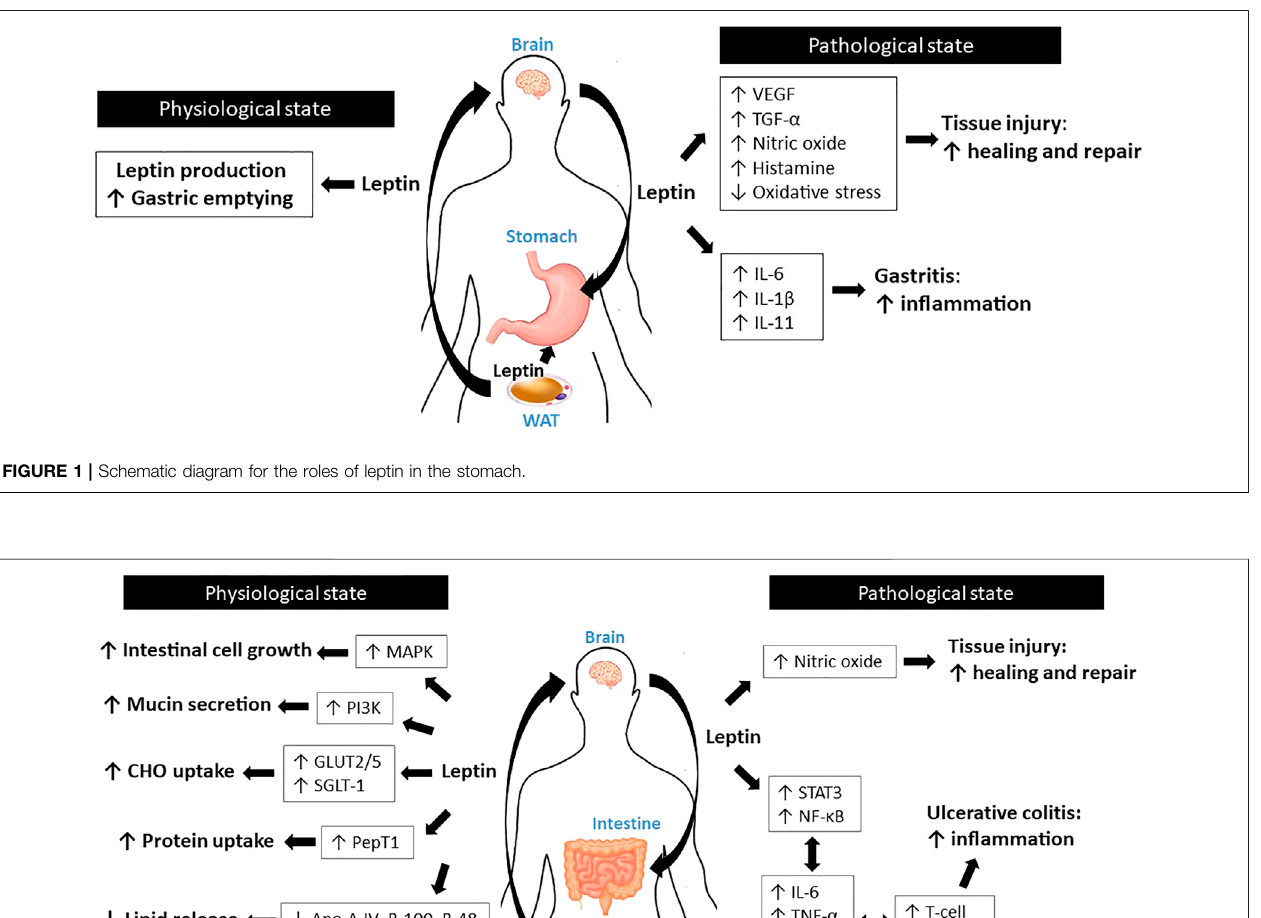
Frontiers in Pharmacology |